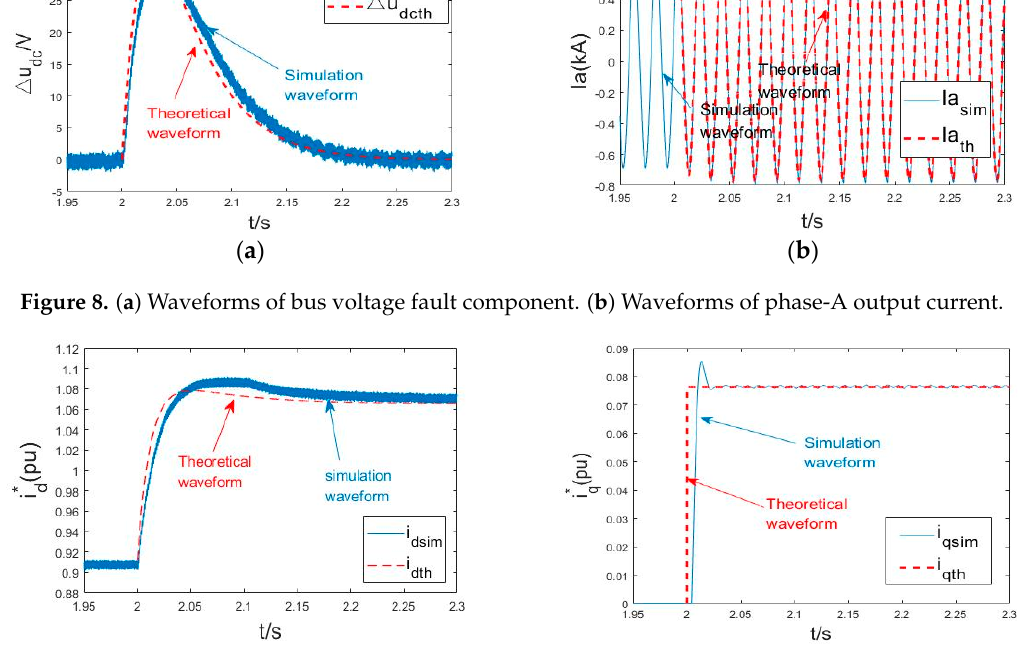
Figure 9. ( a ) Waveforms of d -axis output current. ( b ) Waveforms of q -axis output current.